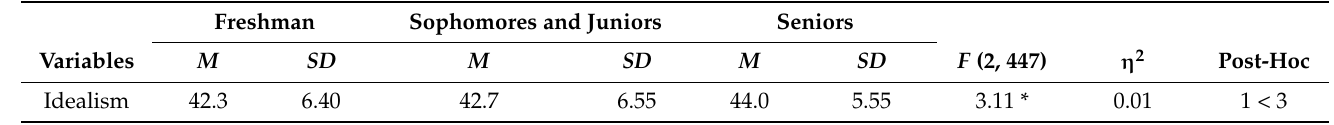
Table 5. Mean, standard deviation and one-way ANOVA in idealism across semesters (N = 450). Freshman Sophomores and Juniors Seniors Variables Idealism